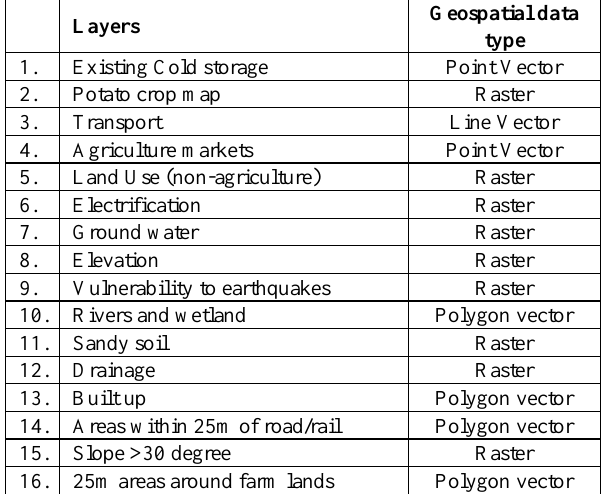
Table 1. Factors and constraints used for the study